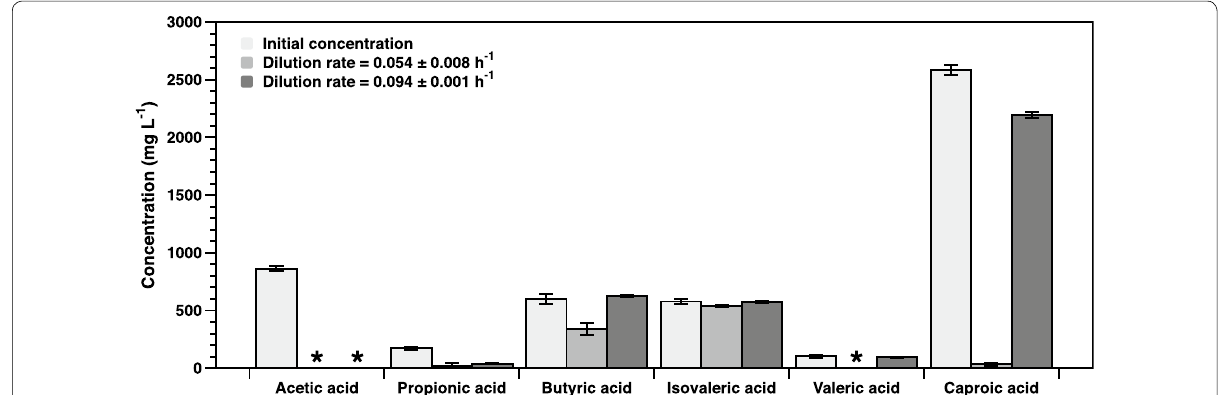
Fig. 2 Residual substrate concentrations in aerobic chemostat cultures of W3110 ΔFadR in minimal salts medium with the indicated mix of VFAs (light grey) as carbon source at pH 7.0 and 37 °C. The bars show average concentrations with standard deviations (n sampled at two different timepoints separated by at least 1/D hours) at two different dilution rates, compared to the initial concentration in the medium. * below the detection limit (10 mg L − 1